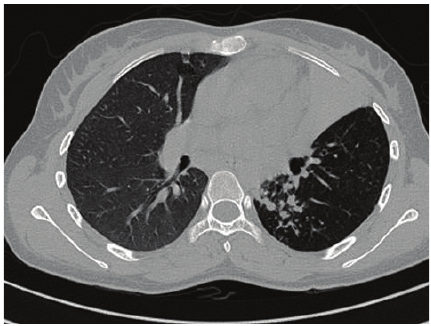
Figure 2: CT thorax showing left upper lobe collapse and infiltra- tions in the lower lobe due to